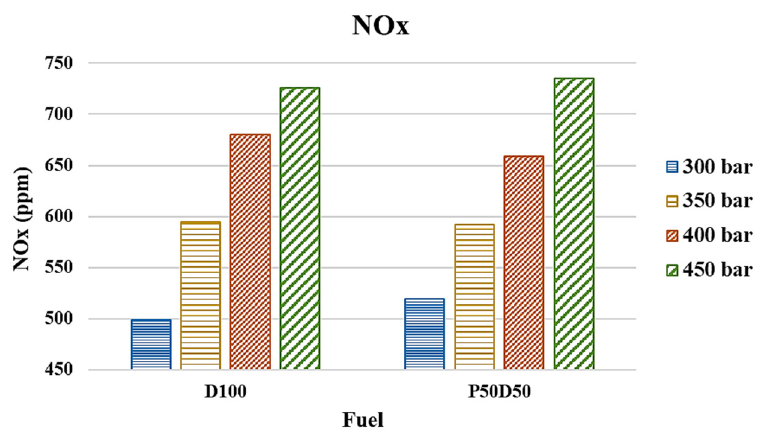
Figure 7. NOx emissions under various injection pressures.